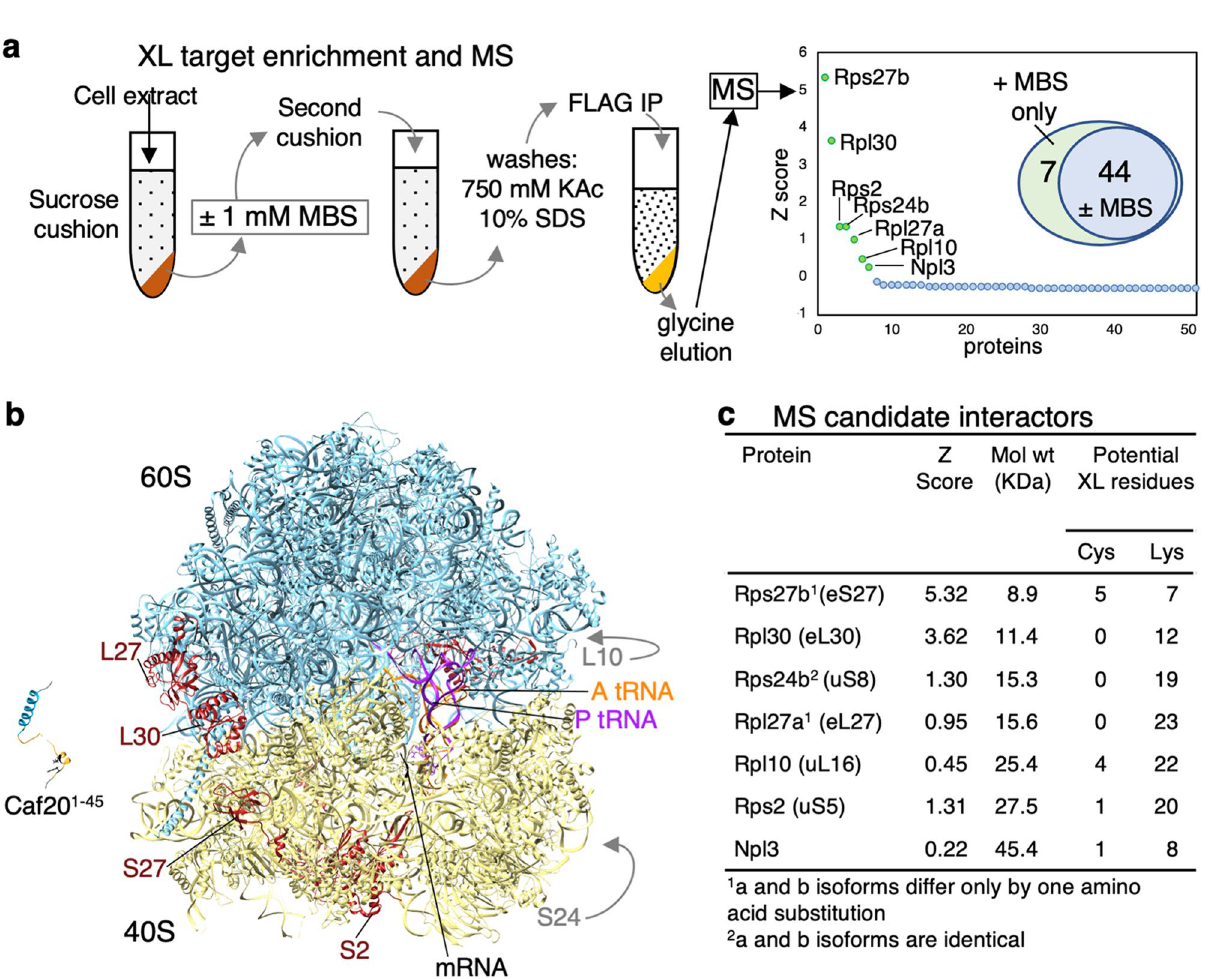
Figure 5. Crosslinking, purification and MS identifies candidate Caf20 interacting proteins. ( a ) XL and purification workflow overview and MS summary identifies 7 novel candidate Caf20 interacting proteins. ( b ) MS candidates placed on 80S ribosome (Pdb:6TNU) 19 , E site view, with Caf201-45 peptide (Pdb: 6FC3) as in Fig. 1 alongside to scale. Figure created with UCSF Chimera v1.15 39 ( c ) properties of candidates